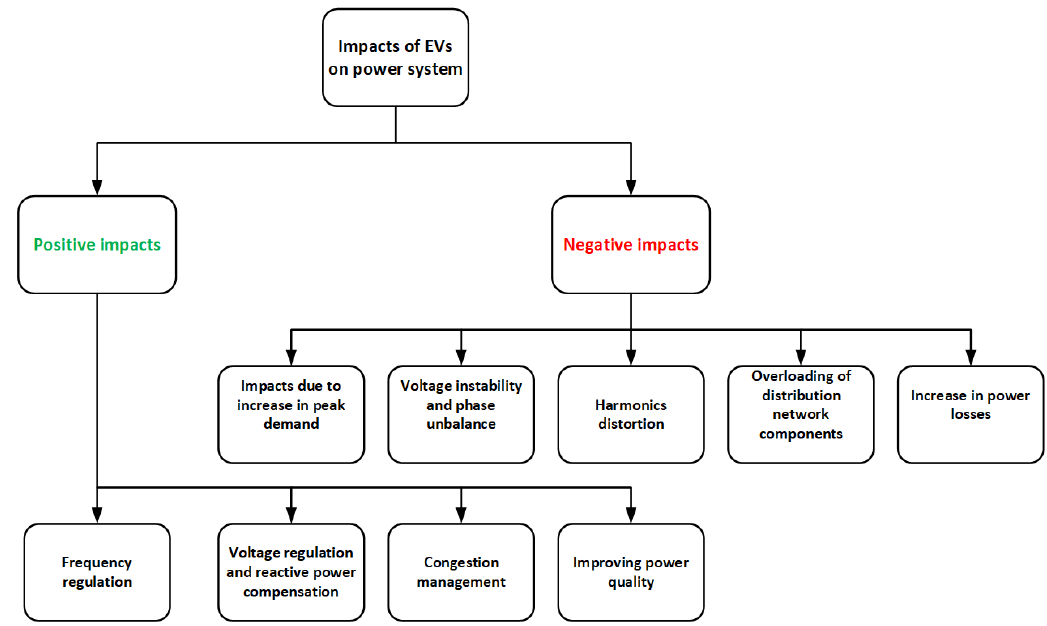
Figure 7. Classification of EVs charging impacts on electric power systems.